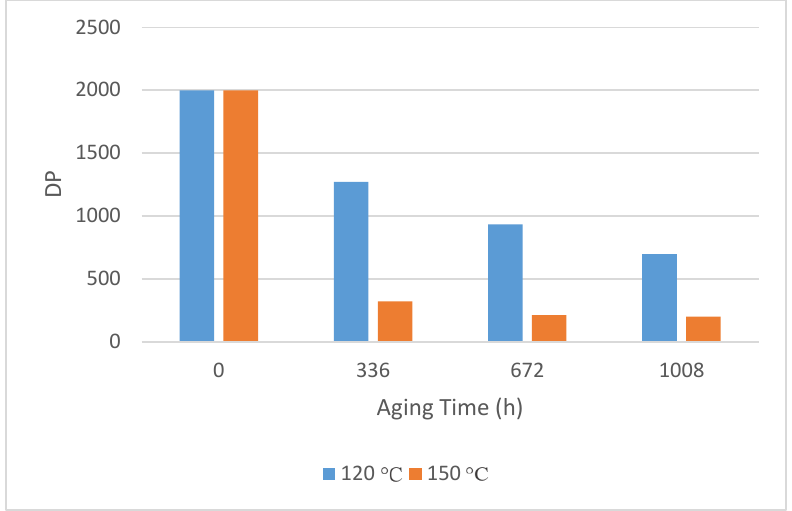
Figure 2. Measured DP of paper samples.